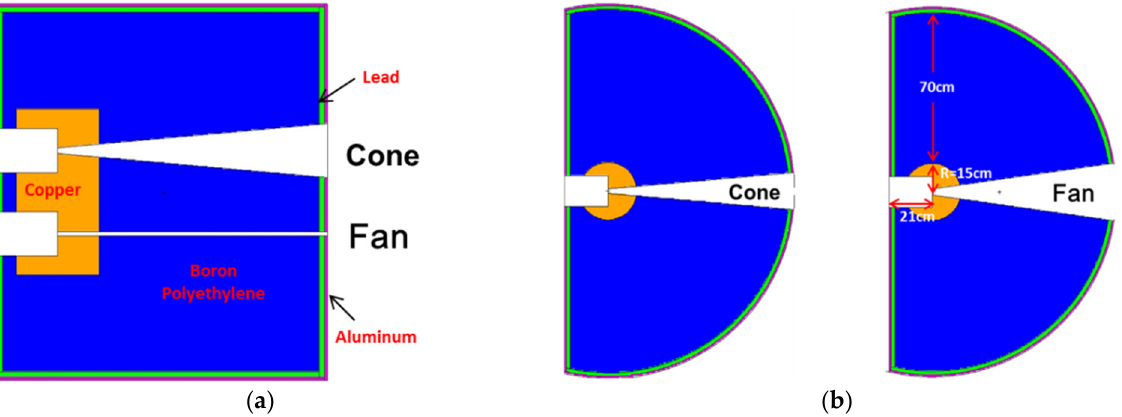
Figure 4. Diagram of collimator: ( a ) Cut-open view in the vertical direction, ( b ) cut-open view in the horizontal direction.